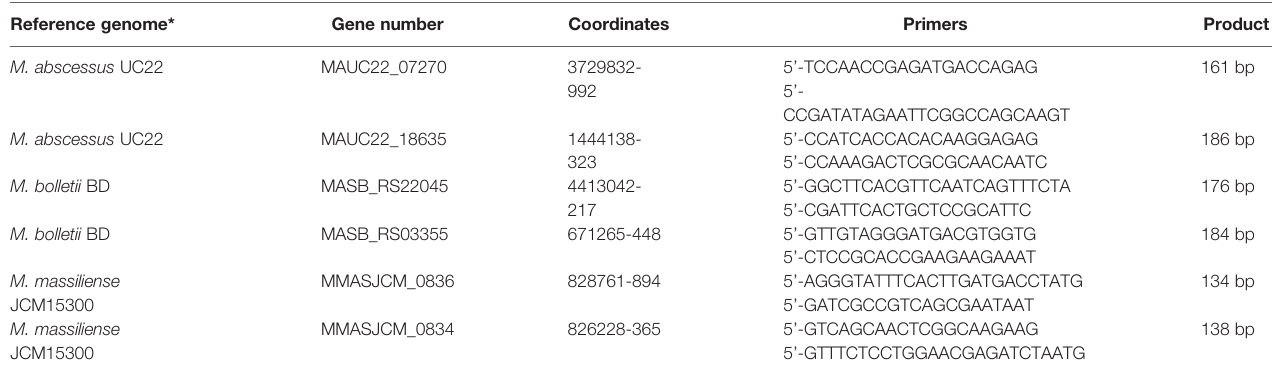
TABLE 1 | Selected genes, product sizes and primer sequences for M. abscessus subspecies-speci fi c PCRs. Reference